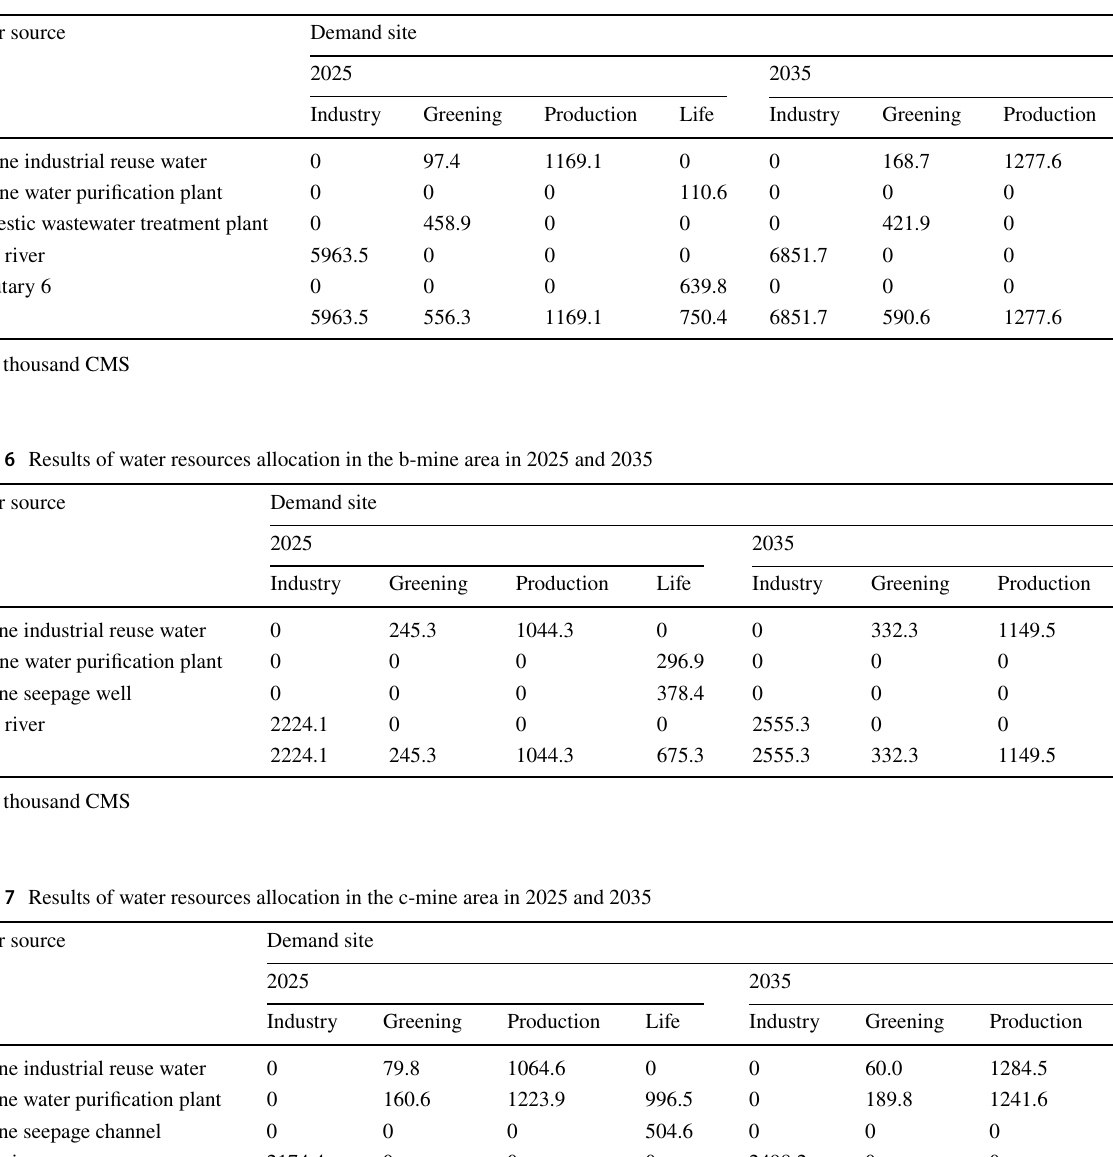
Table 5 Results of water resources allocation in the a-mine area in 2025 and 2035